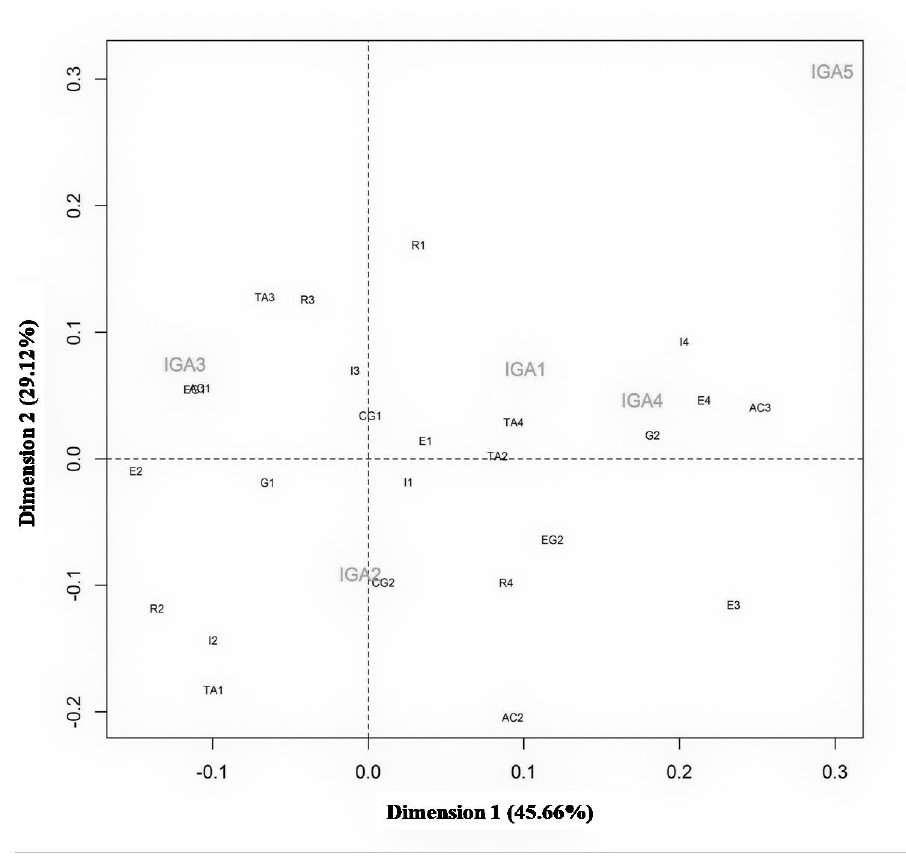
Figure 1. Correspondence Map of the multiple choice items on teachers’ perception about genetic and environmental influence in Intelligence and the sample